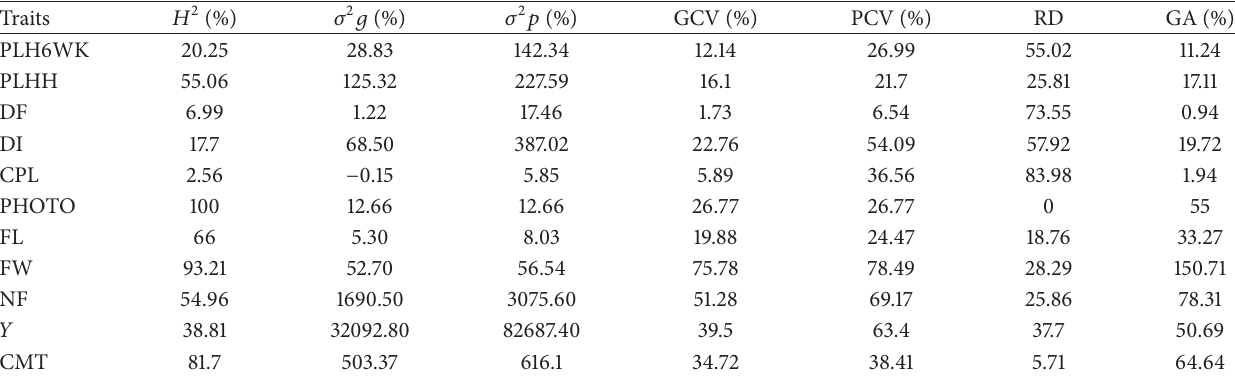
Table 7: Estimate of broad sense heritability, genotypic, and phenotypic coefficients of variance, relative differences between GCV and PCV, and genetic advance for ten traits in 36 Capsicum spp